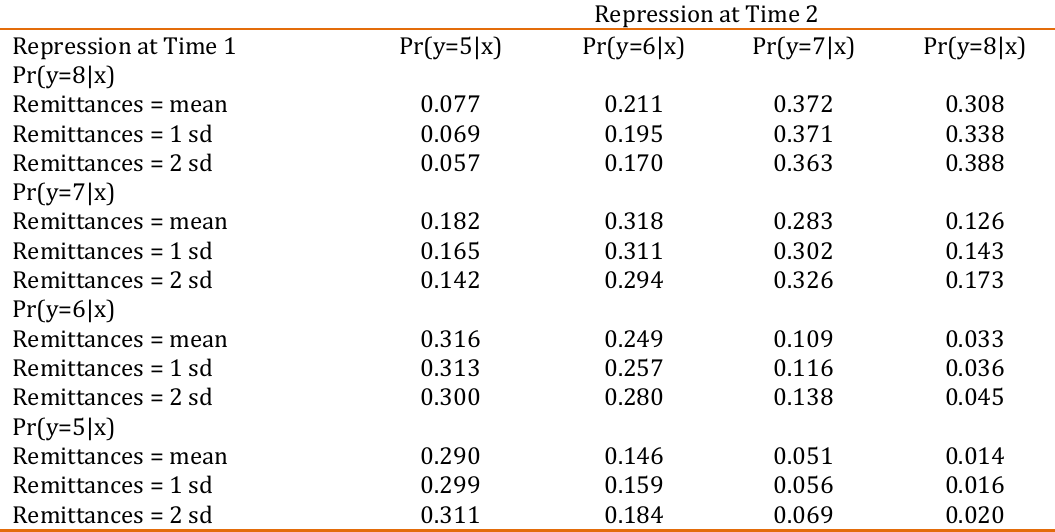
Table 03. Effect of remittances on the level of violations to the rights to physical integrity (1981 – 2014), predicted probabilities